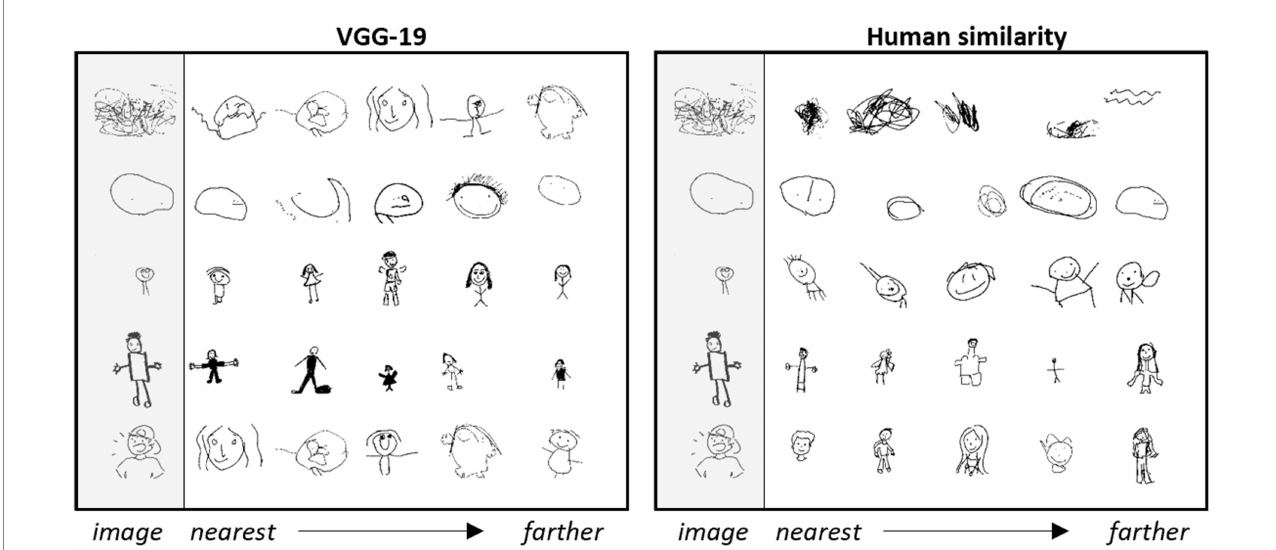
FIGURE 6 K-nearest neighbors of five-dimensional embedding spaces. Nearest neighbors for five reference items in the 5D embedding space for machine- (left) or human- (right) derived latent feature vectors. Rows show the five closest neighbors to the reference item (gray column) in order of proximity. The same reference items are used in each space, but the two spaces capture different neighborhood relations.